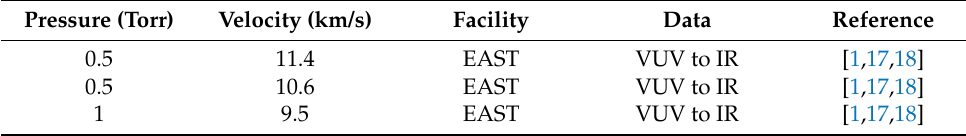
Table 7. Venus entry conditions investigated with shock-tube